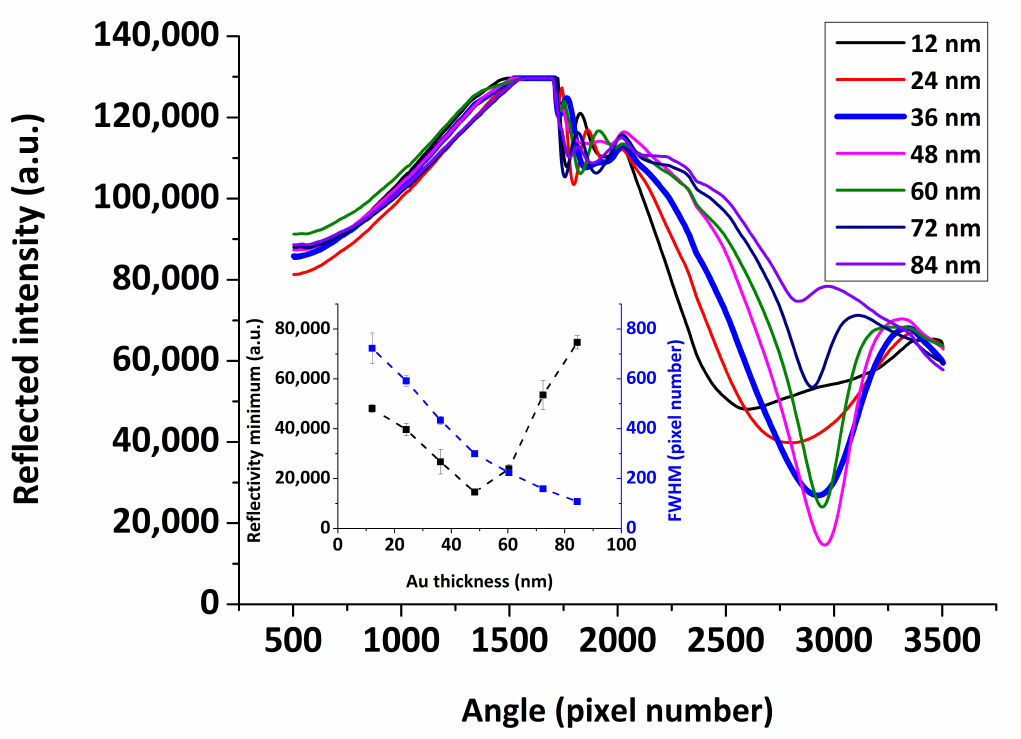
Figure 7. SPR reflectivity curves versus angle pixel number for various Au layer thicknesses. ( inset ) FWHM and minimum reflectivity as a function of the Au thickness.